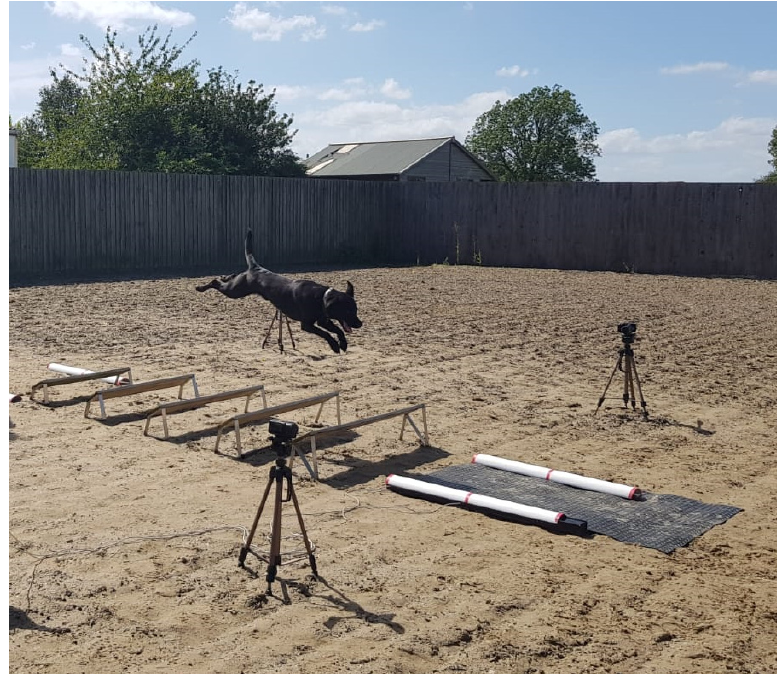
Figure 1. Long jump study setup showing the positioning of pressure sensing mat (under protective rubber sheeting) on the landing side.